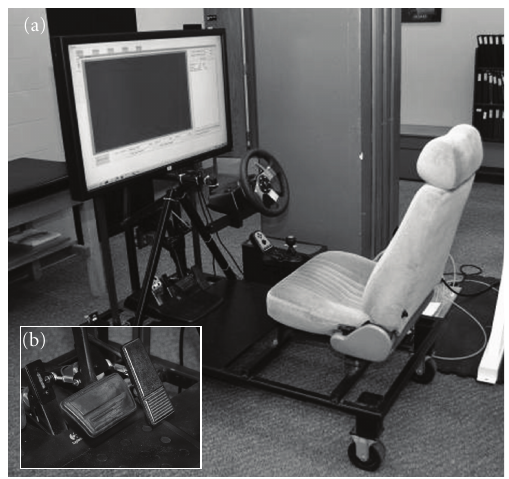
Figure 2: Driving simulator (a) and closeup of accelerator and brake pedal (b) used in the high-speed functional